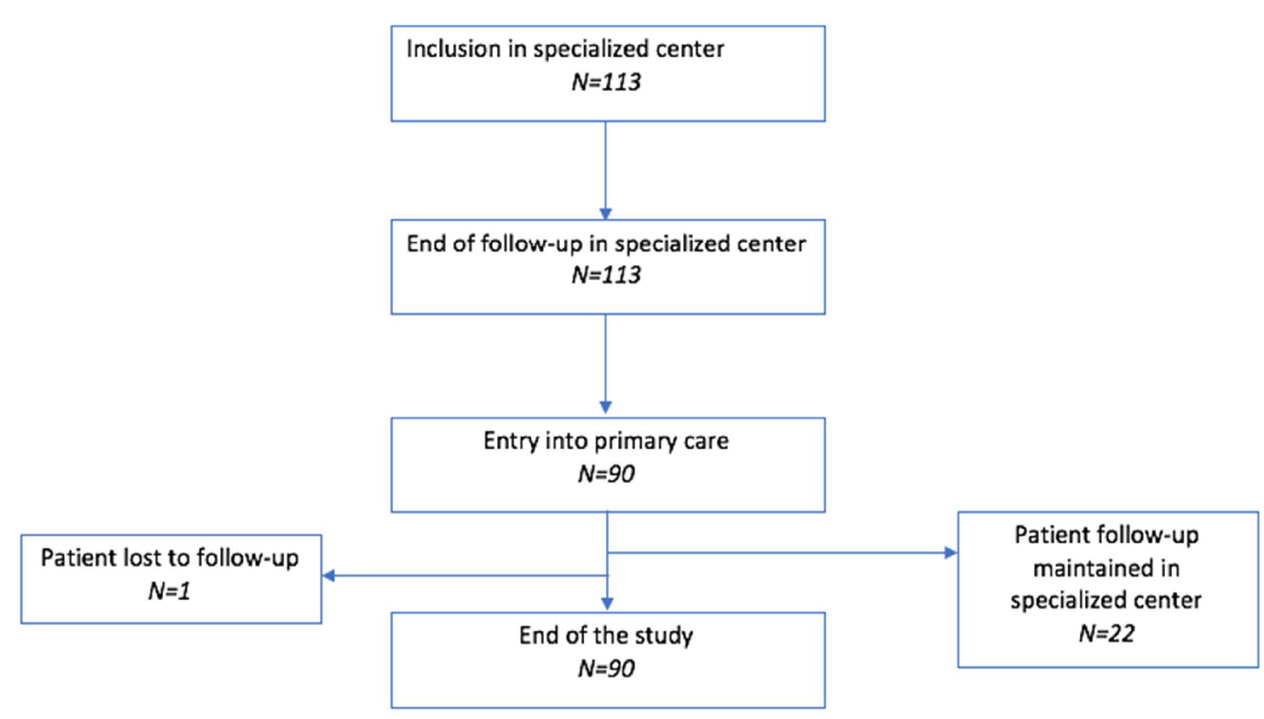
Figure 1. Study flowchart. ( N = Number of patients).